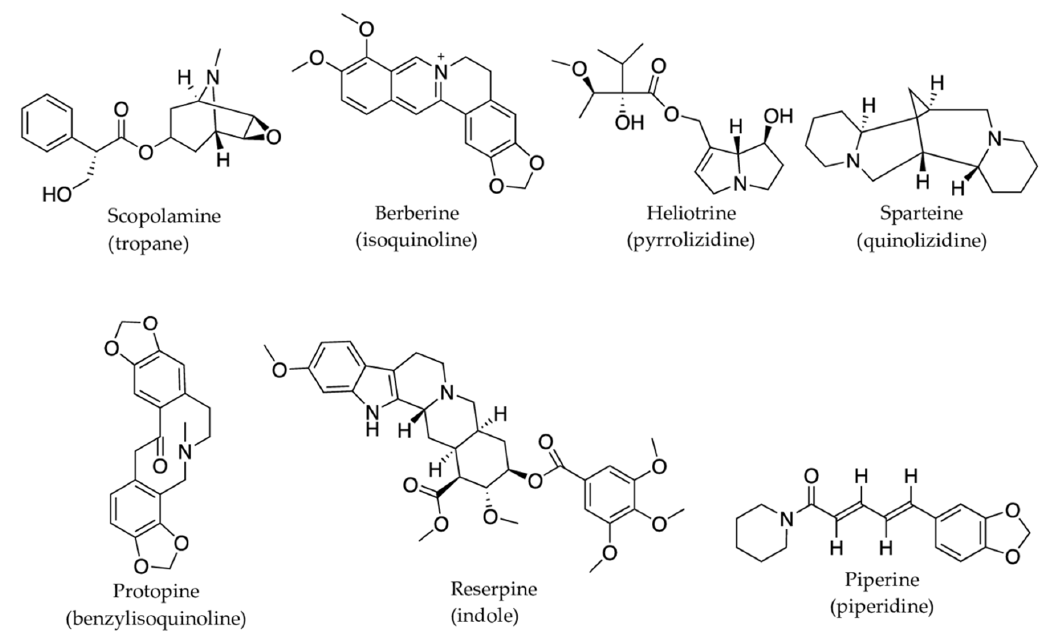
Figure 3. Representative examples of seven different types of alkaloids produced in plants and their chemical structure.